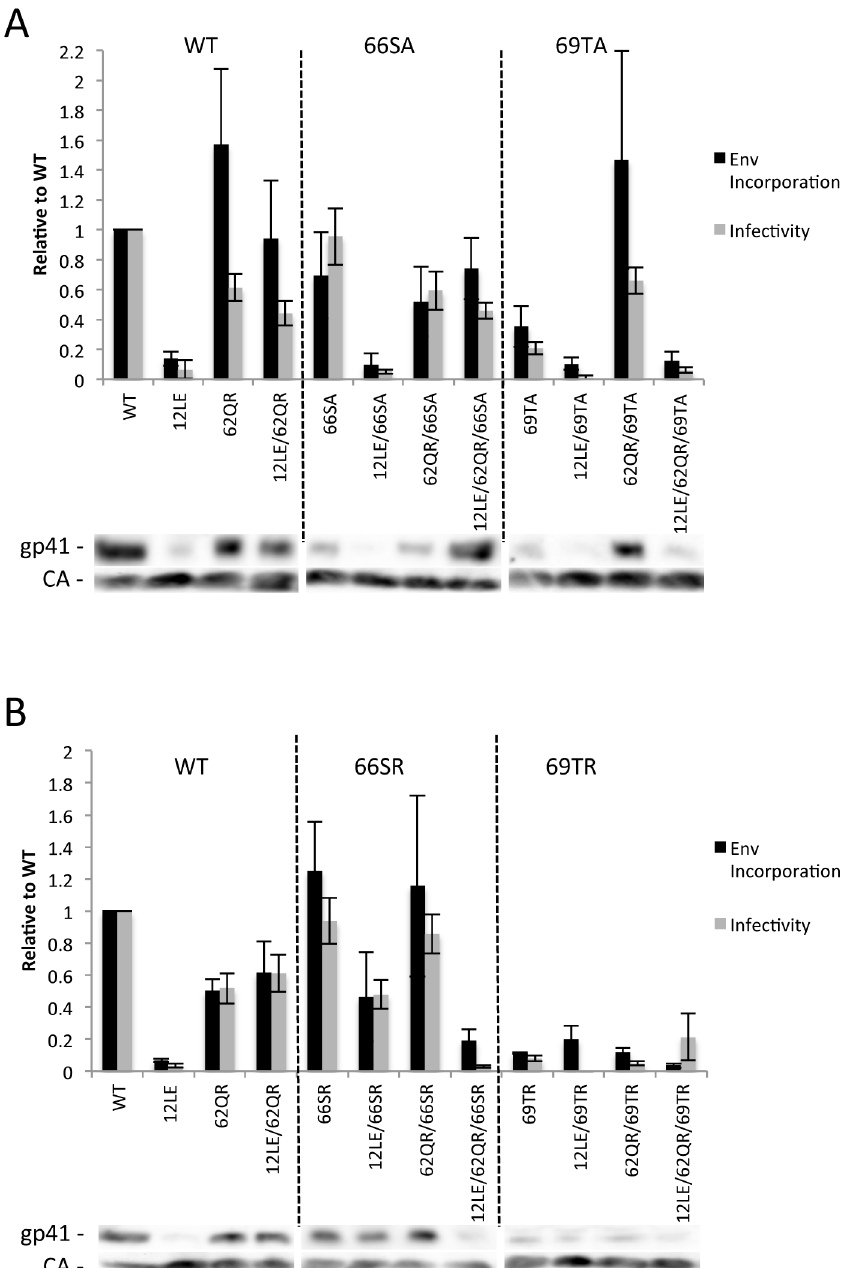
Figure 7. The effect of mutations at the trimer interface on rescue of Env incorporation. 293T cells were transfected with the indicated molecular clones. At 24 h, supernatants were harvested and assayed for infectivity as described in Materials and Methods. Infectivity is expressed relative to the WT value. Supernatants were also filtered and virions pelleted, lysed, and probed by western blotting for gp41 and CA. Env incorporation was determined as described in Materials and Methods and is indicated relative to WT. Representative blots are shown below each graph. n=5–7, + / 2 SEM. (A) Ala mutants of S66 and T69. (B) Arg mutants of S66 and T69.